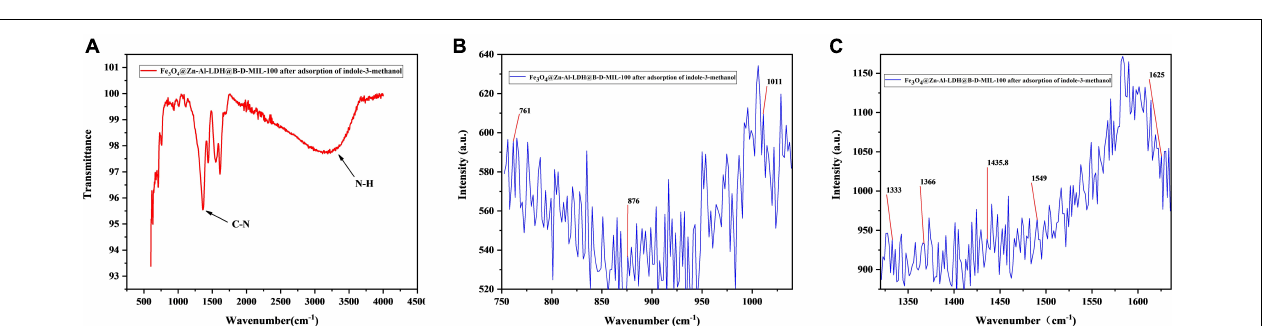
FIGURE 5 | (A) FT-IR, and (B,C) Raman spectra of composite with extracted I3C.